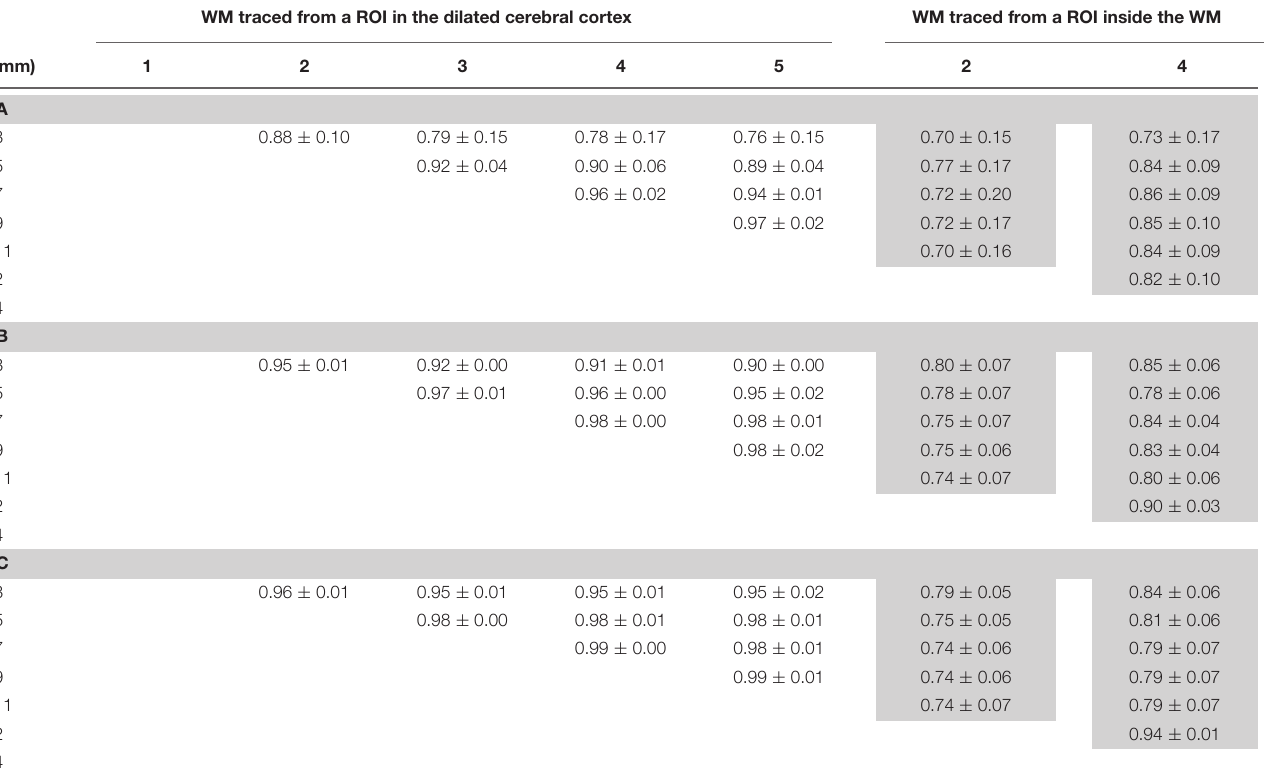
TABLE 2 | Mean Dice ratios and standard deviations of the WM fibers traced from the left precentral gyrus (A), left lateral orbitofrontal gyrus (B), and left superior frontal gyrus (C) using two different evaluation tests by adjusting the seed region of interest (ROI) for WM tracing. WM traced from a ROI in the dilated cerebral cortex WM traced from a ROI inside the WM